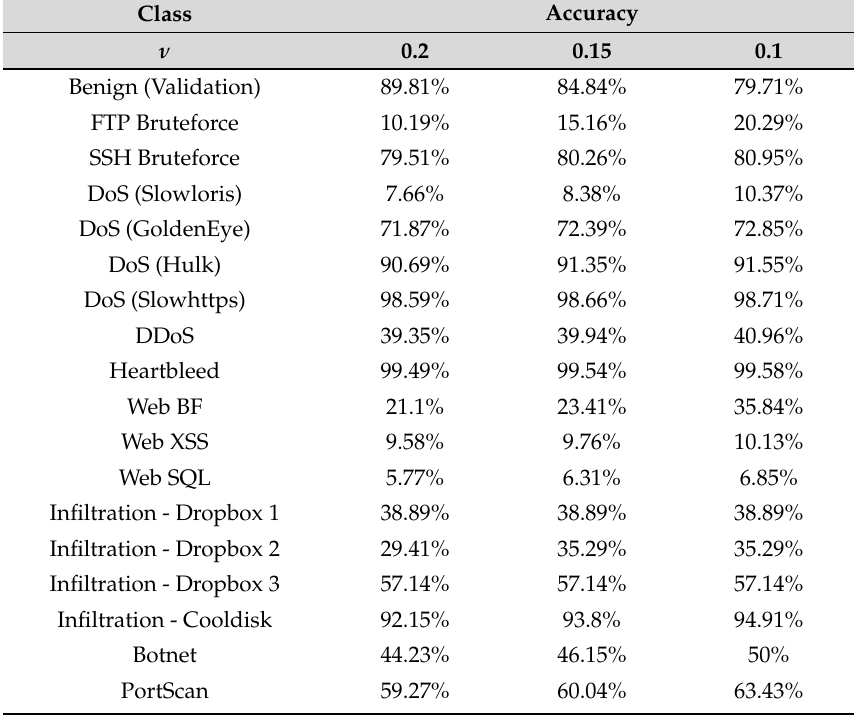
Table 2. CICIDS2017 One-Class Support Vector Machine (SVM)